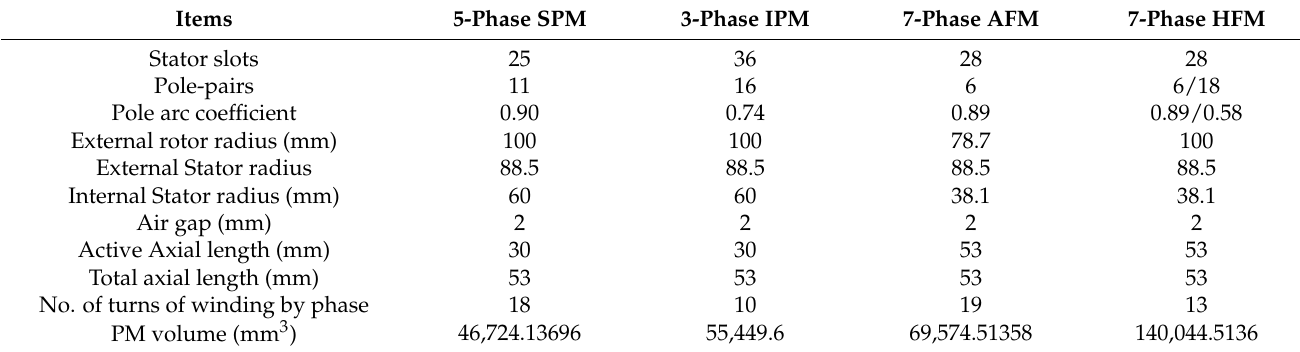
Table 1. Main parameters of the four